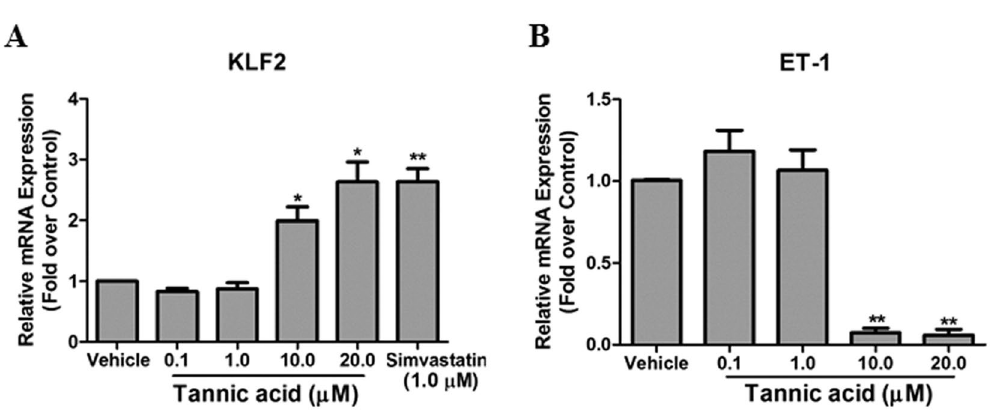
Figure 1. Identification of TA as a KLF2 activator. ( A ) Chemical structure of the TA. ( B ) KLF2 luciferase activity was analyzed in COS-7 cells transfected with KLF2-luciferase plasmids treatment with DMSO (vehicle), TA (0.1, 1.0, 10 and 20 μ M) or simvastatin (1.0 μ M). ** P < 0.01, Student’s t test. Values represent mean ± SEM; n = 4.